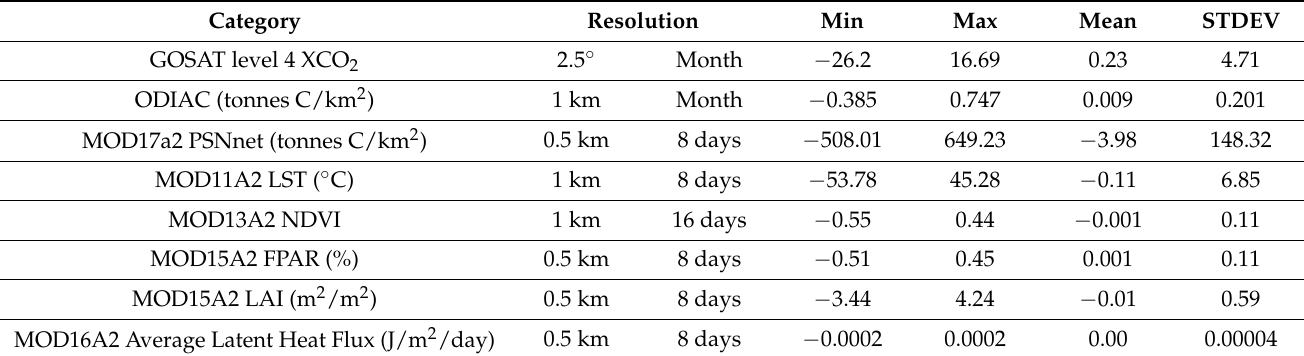
Table 1. Descriptive statistics for monthly anomalies of dependent and independent variables used in